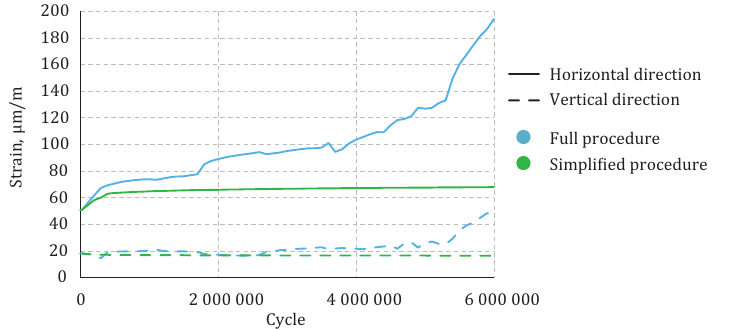
Figure 9. Dependence of strains on loading cycles